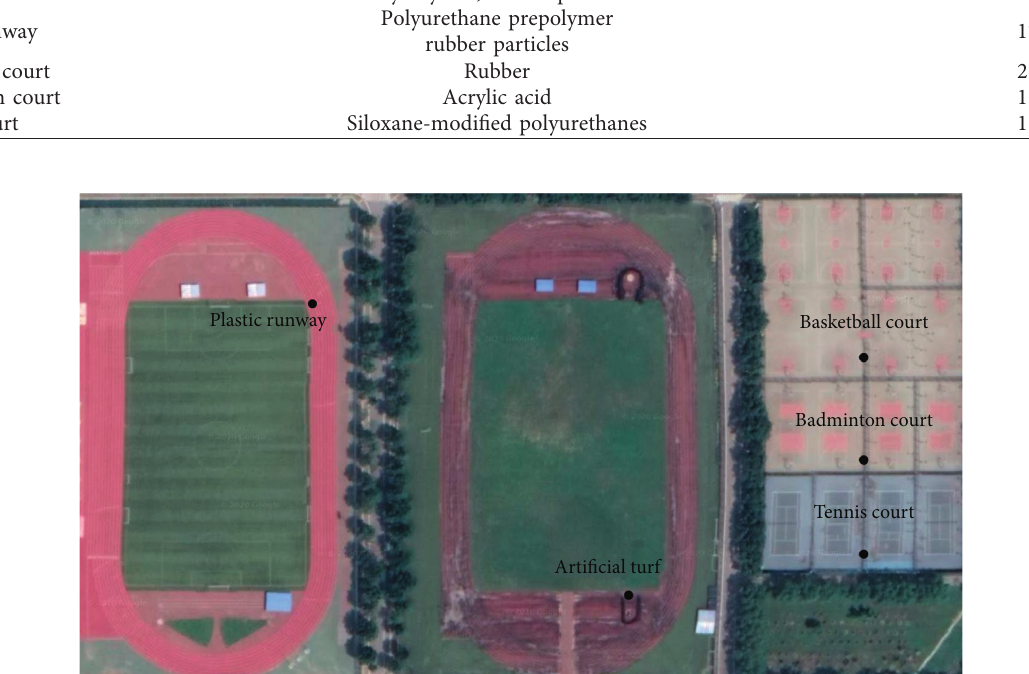
Table 1: Main characters of the underlying surface of the five athletic fields. Sampling area